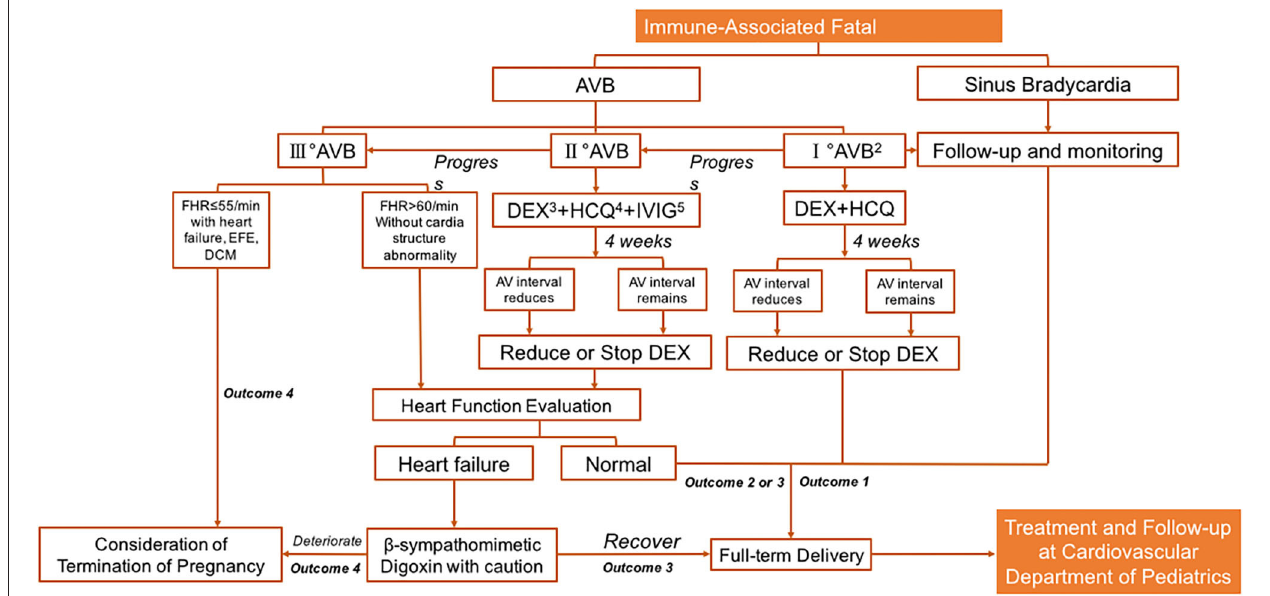
FIGURE 1 | Prenatal management for immune-associated bradycardia. Note 1: Immune-associated: this figure refers specifically Anti-Ro/SSA ( + ) or Anti-La/SSB ( + ). Note 2: PR interval > 150 ms. Note 3: Dexamethasone: 4–8 mg/qd, monitor the decrease of amniotic fluid, the length of fetal femur and the delay of fetal biparietal diameter by 2 weeks etc. Reduce and stop drugs in time. Note 4: Hydroxychloroquine: 200mg po bid, continuous use during pregnancy. Outcome 1: I ◦ AVB and sinus bradycardia do not require pacing therapy in childhood, and long-term follow-up is performed. Note 5: Intravenous immunoglobulin usage: (1) 1 g/Kg ivgtt, twice a week for 2 weeks, and then used according to the situation; (2) 1 g/kg ivgtt at 16–30 weeks of gestation, and 1 g/kg ivgtt once a month after 2 weeks of continuous use. Outcome 1: The sinus bradycardia and part of I ◦ AVB patients do not need treatment during fetal stage, and continuous observation is required. Outcome 2: II ◦ AVB: most patients do not need pacing therapy after birth. According to their growth and development and clinical symptoms, protective or therapeutic pacing therapy can be considered. Outcome 3: For II ◦ AVB or III ◦ AVB with symptomatic bradycardia, cardiac dysfunction or low cardiac output; Congenital III ◦ AVB with wide QRS, ventricular ectopic or cardiac dysfunction; Congenital III ◦ AVB with ventricular rate lower than 55 times/min; Asymptomatic congenital patients with III ◦ AVB and not wide QRS and normal cardiac function, a protective pacemaker may be considered for treatment. Outcome 4: Death in utero ; Or a referral to a general hospital that can provide rapid life support and intrapartum pacing therapy. AVB, atrioventricular block; FHR, fatal heart rate; AV interval, the time interval between the beginning of atrial systole and the beginning of ventricular systolic ejection; EFE, endocardial fibroelastosis; DCM, dilated